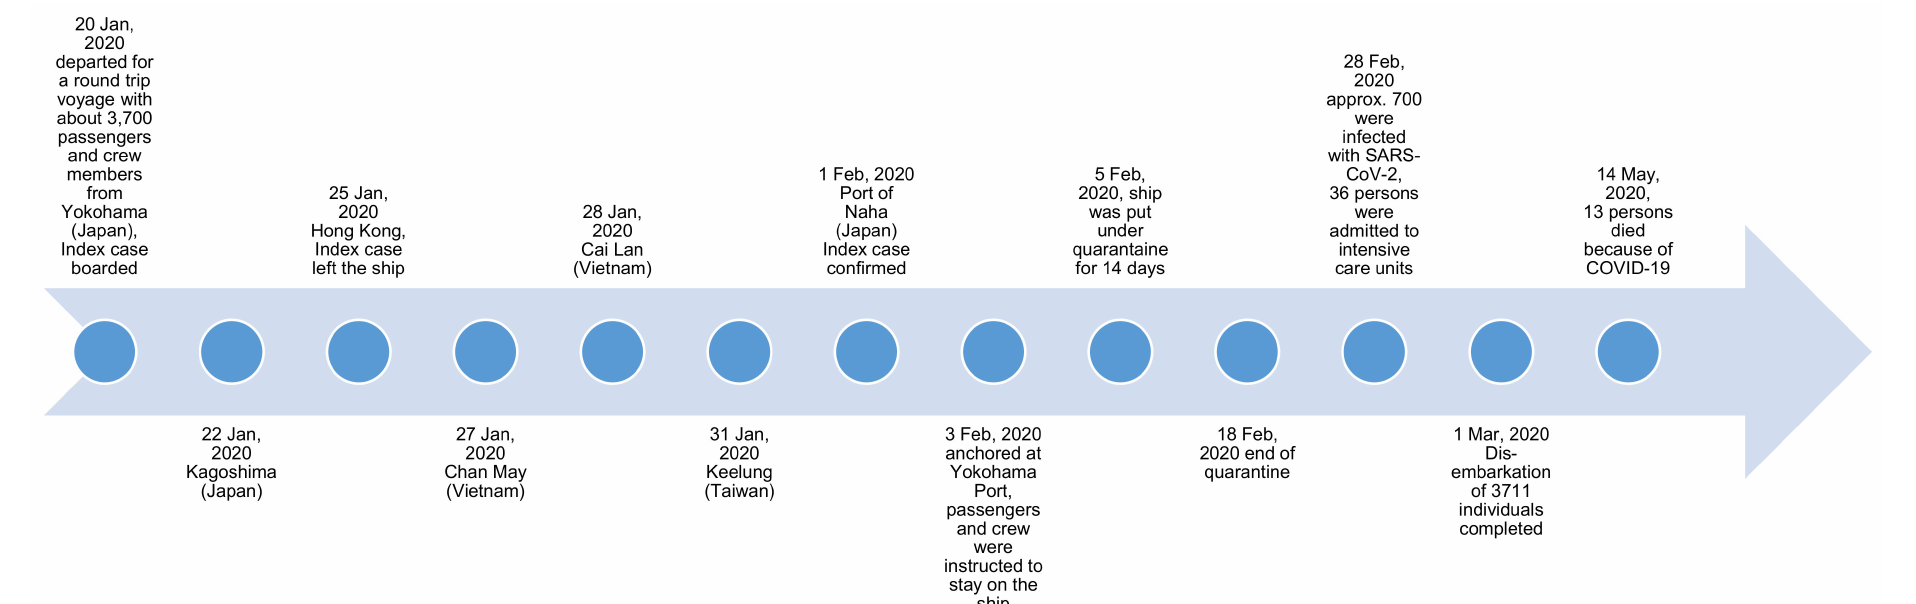
Figure 2. Course of the SARS-CoV-2 outbreak on the Diamond